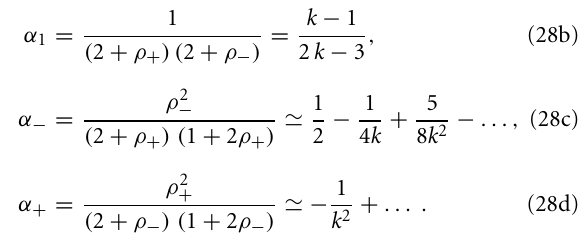
those in Figure 3 (“data”) show the numerical results for a progression of (cid:6) (cid:7) R 2 as suggested in time on a logarithmic scale. We provide here data where (cid:2) R (cid:3) grows to a size (cid:2) R (cid:3) (cid:4) 100. As function of x the CDFs are slowly broadening in time (insets). As function of ˜ x they approach an asymptotic distribution (“final”) that is provided by dotted gray lines in the main